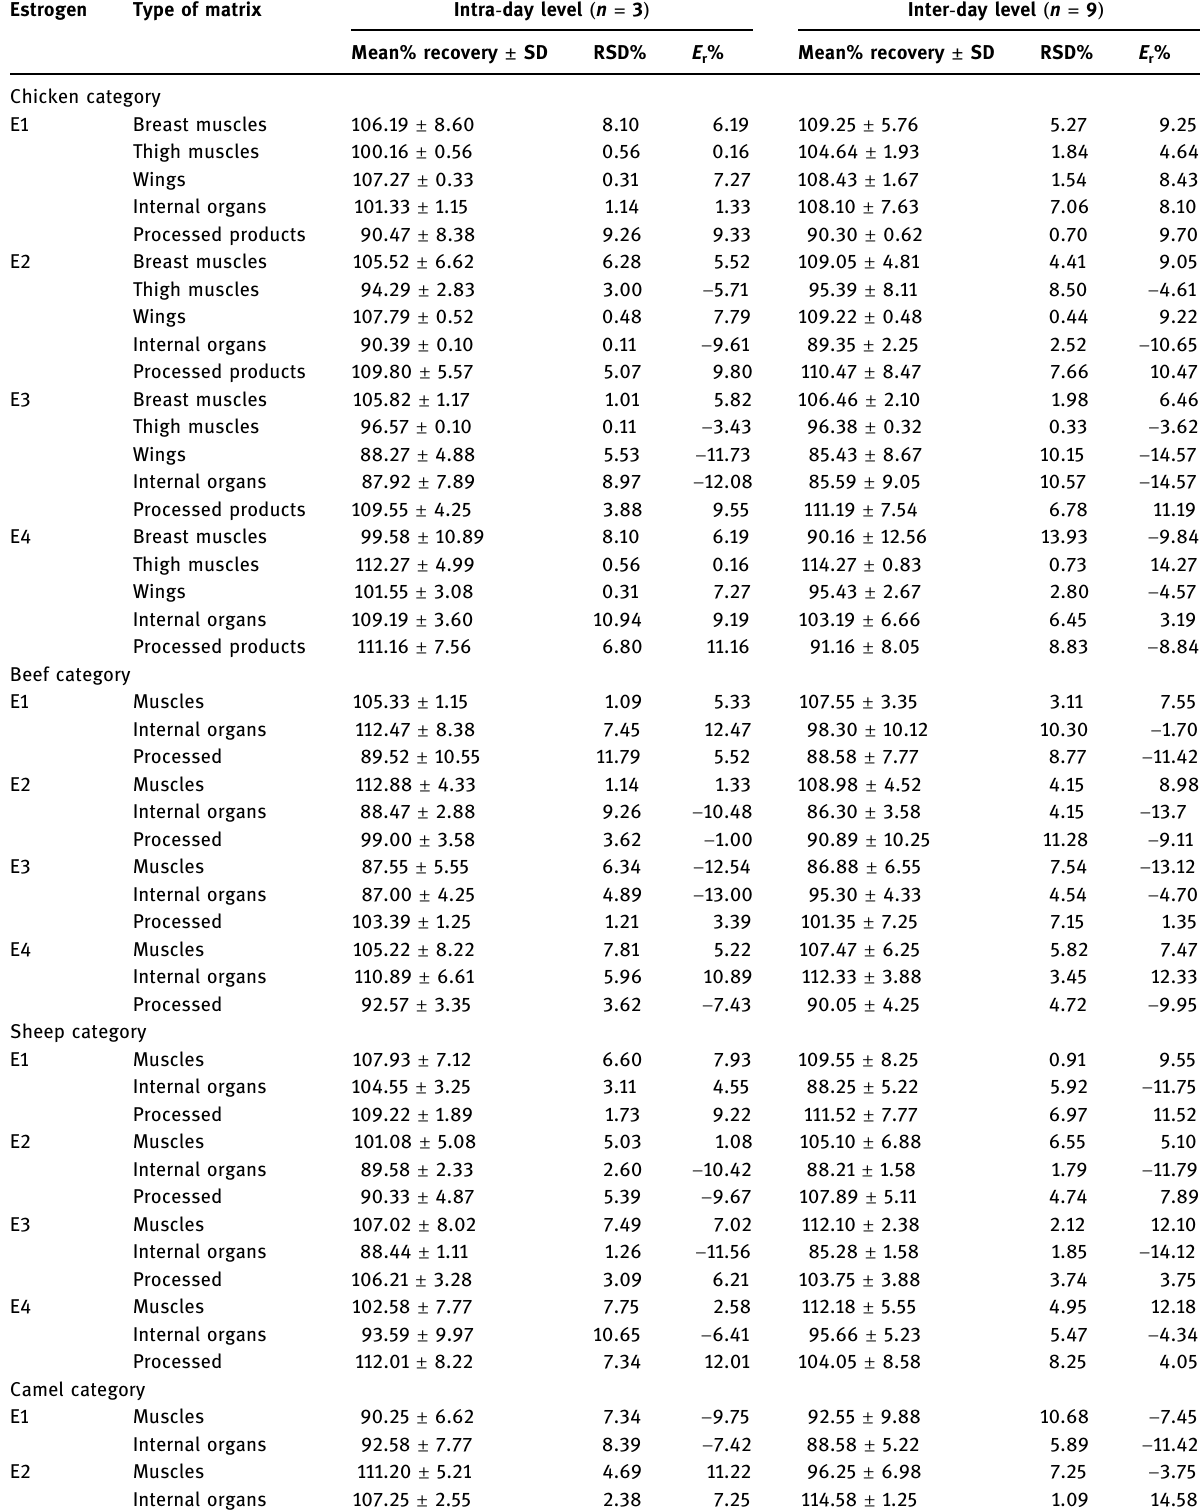
Table 2: Average results a for evaluating the precision and accuracy for the determination of estrogens in di ff erent meat categories using the proposed HPLC - DAD